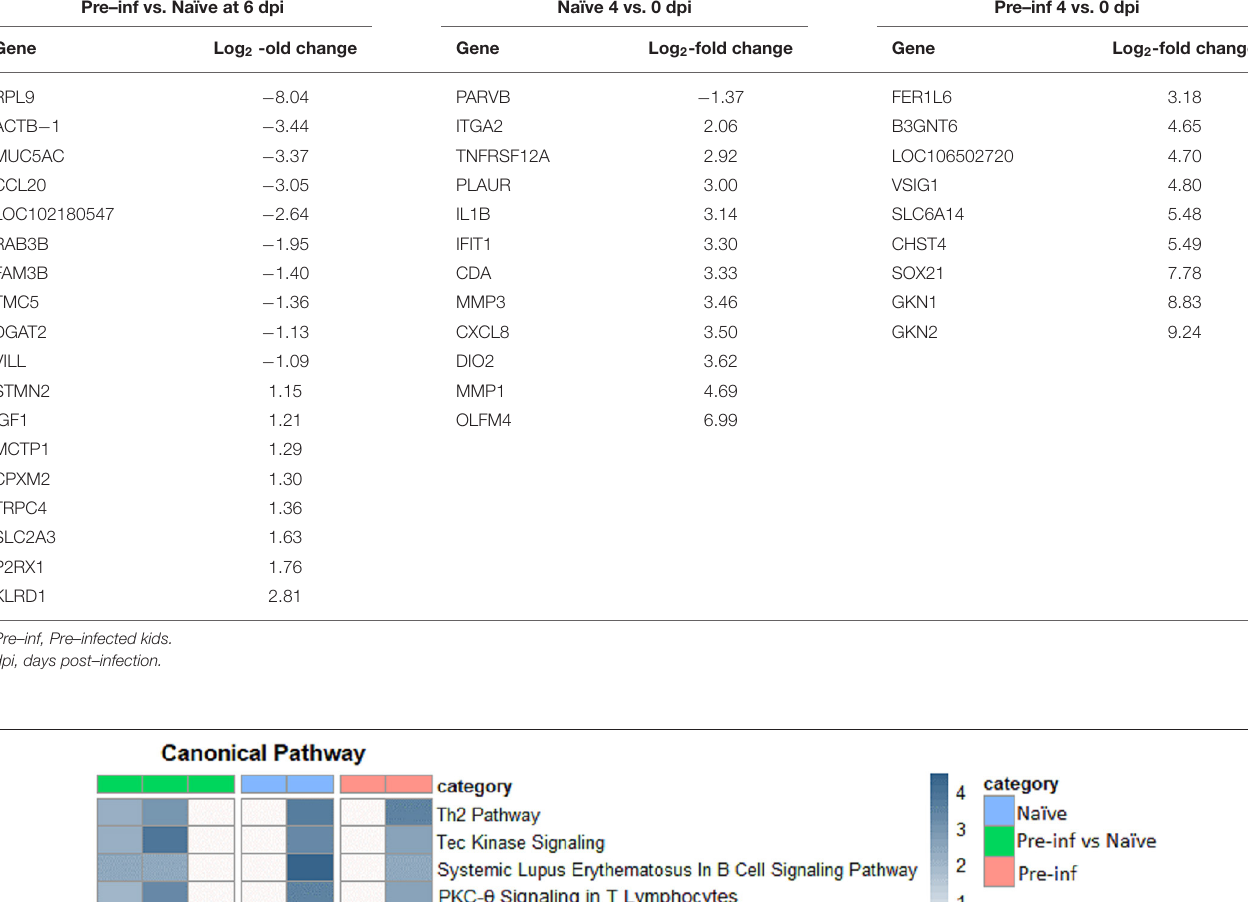
TABLE 2 | Differentially expressed genes (DEGs) and log 2 –fold change for pre–infected and naïve kids at 6 days post–infection (dpi), naïve and pre–infected comparing 0 and 4 dpi. Pre–inf vs. Naïve at 6 dpi